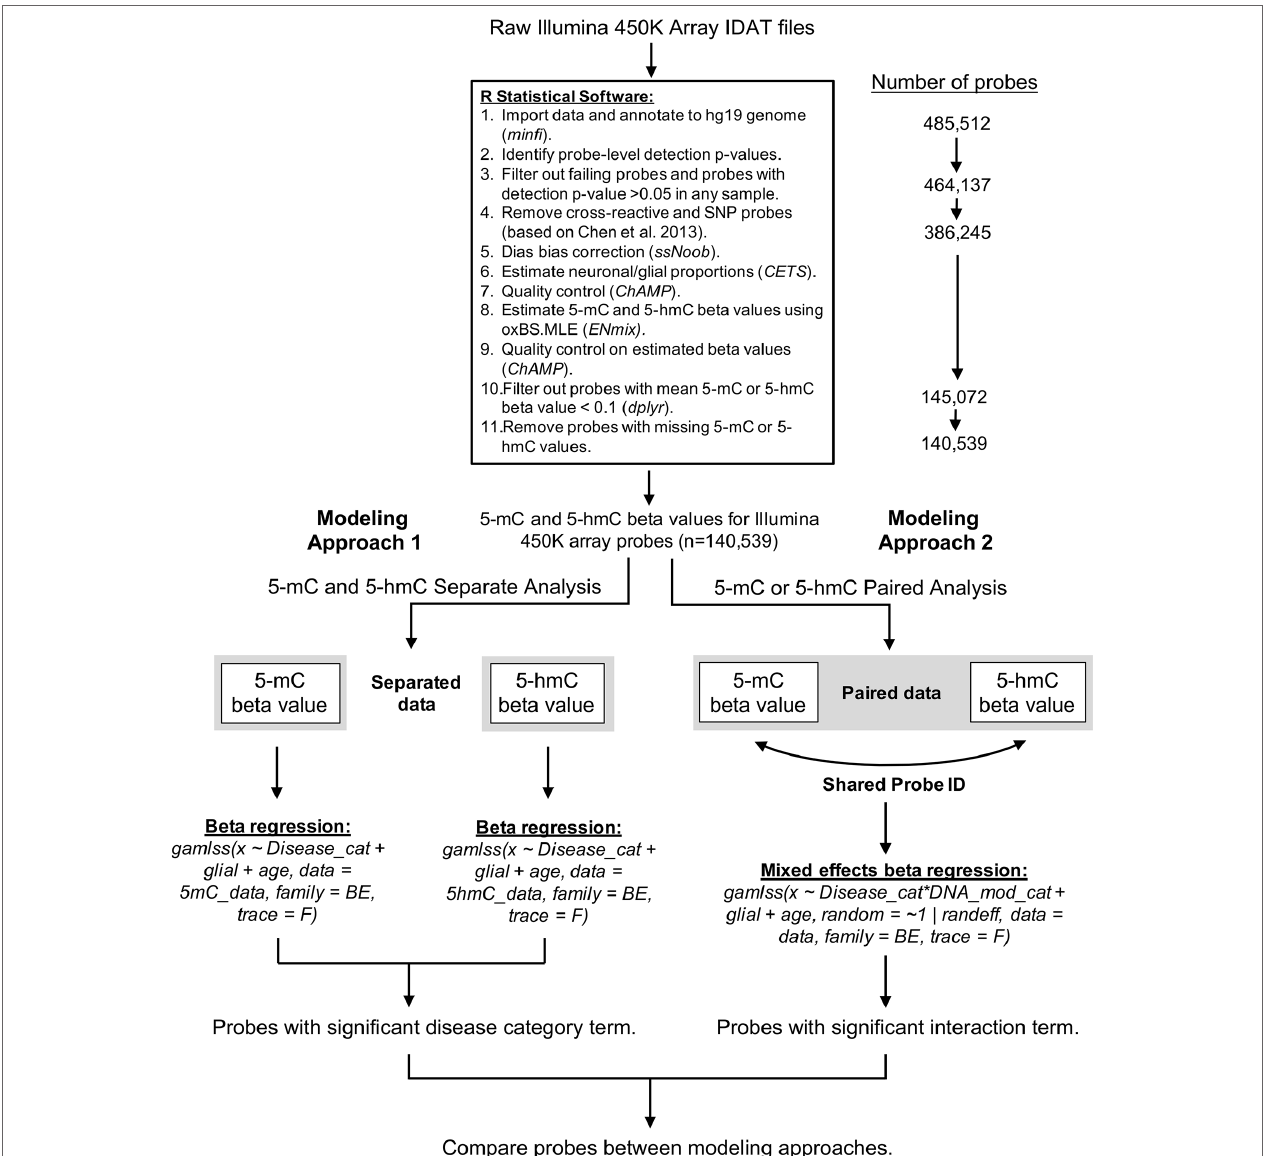
FIGURE 6 | Bioinformatics pipeline for oxBS-450k analyses. The described bioinformatics pipeline was used to perform both paired and parallel modeling of 5-mC/5hmC by AD status. Publicly available Illumina 450K array IDAT files were sourced from Gene Expression Omnibus accession GSE105109 (Smith et al., 2019). All data processing and analysis were performed using R statistical software (version